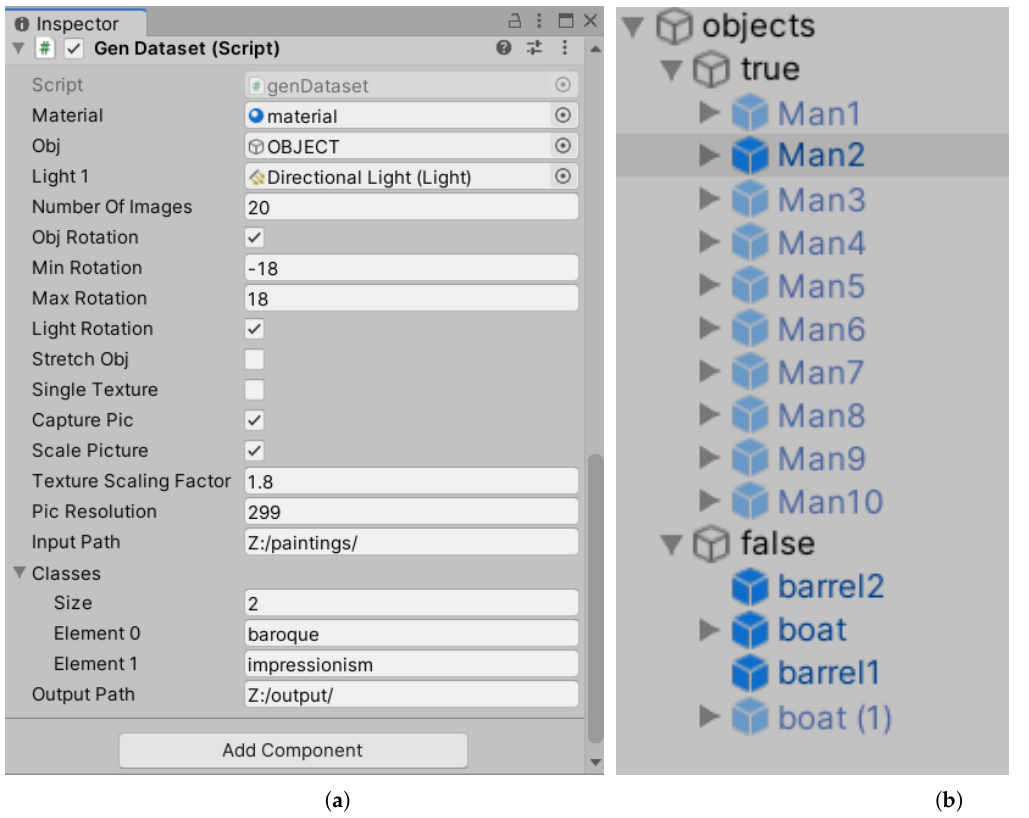
Figure 16. Unity3D interface. ( a ) Inspector, the script and the parameters; ( b ) Objects in the